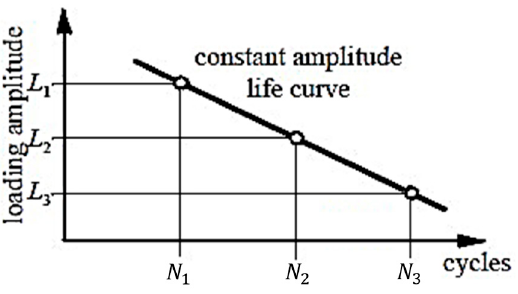
Figure 1. Scheme of different loading amplitude versus solder lifetime cycles.